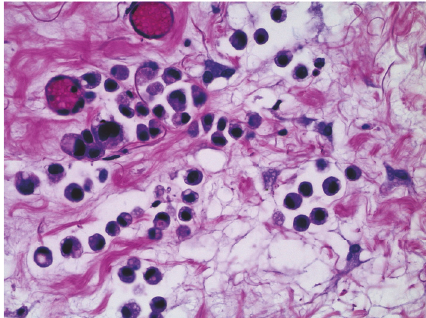
Figure 1: Transurethral bladder resection specimen displaying plas- macytoid tumor cells, with eccentric nuclei and eosinophilic cyto- plasm. There is occasional intracytoplasmic vacuolization (H&E, × 400).